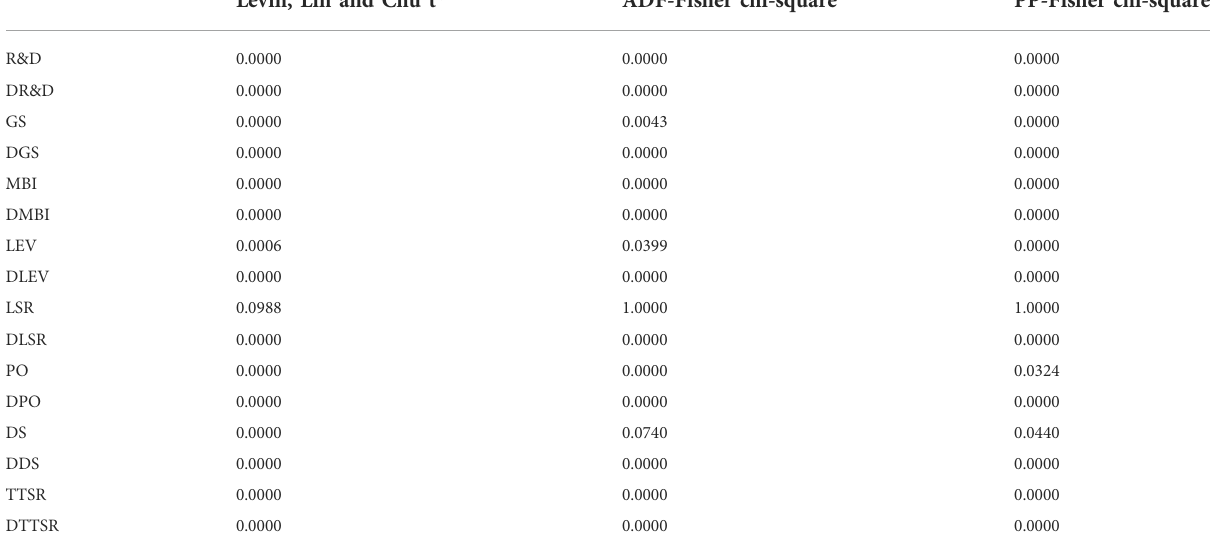
TABLE 4 Unit root test results.